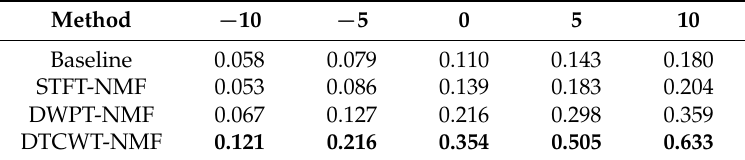
Table 1. The HASQI results in five SNR cases.